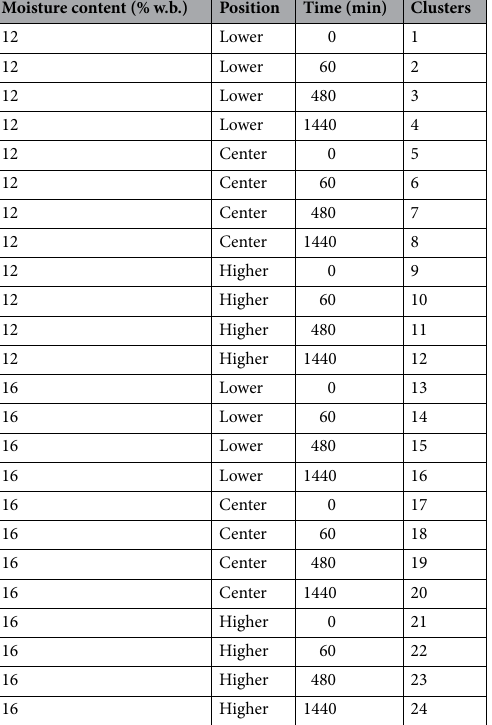
Table 1. Multivariate statistics as a function of initial grain water content, position/layer and grain monitoring